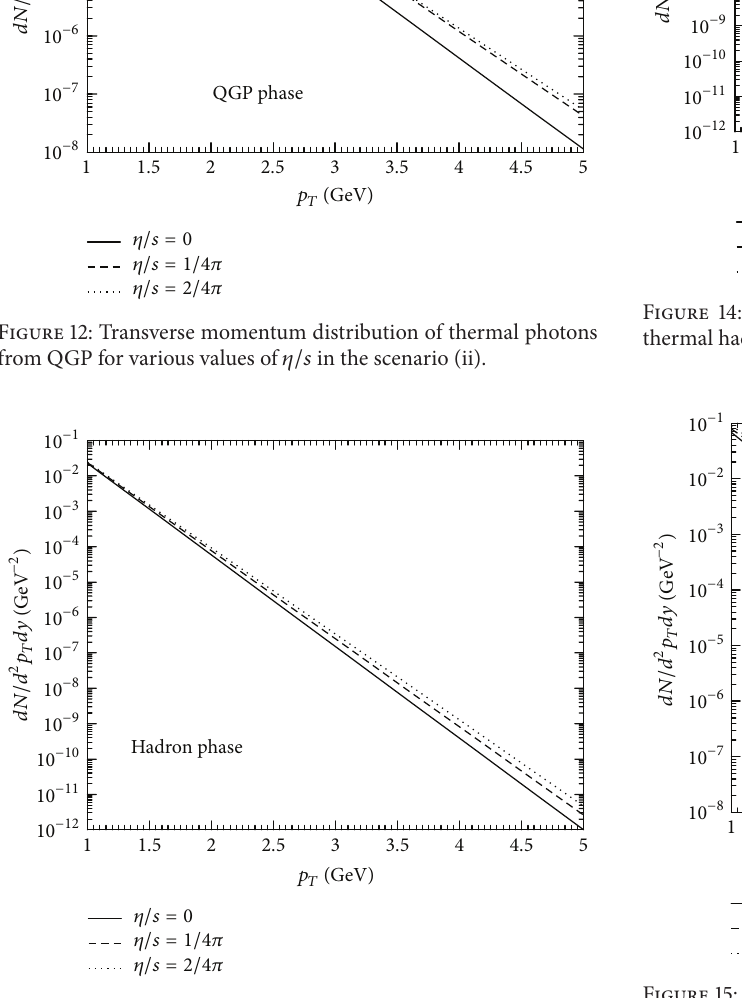
Figure 13: Transverse momentum distribution of photons from thermal hadrons for various values of 𝜂/𝑠 in the scenario (i).